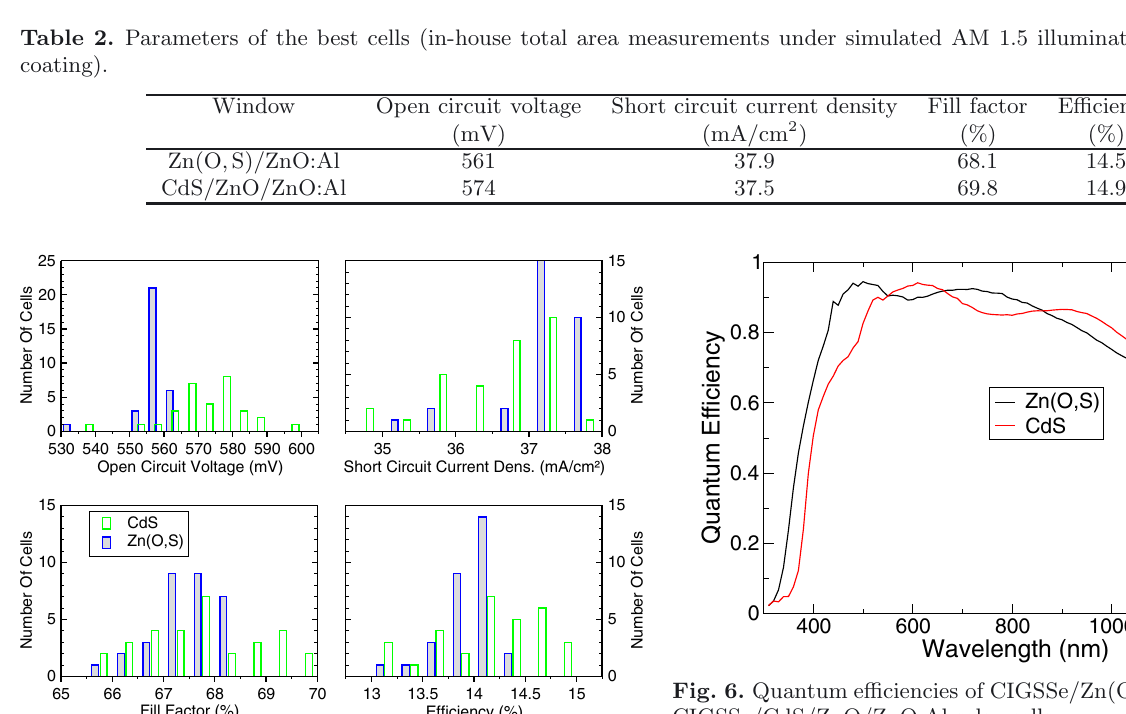
Fig. 5. Distribution of the parameters of small (0.5 cm 2 ) cells with Zn(O, S)/ZnO:Al and CdS/ZnO/ZnO:Al windows on 5 × 5 cm 2 substrates (see text) as measured under simulated AM 1.5 illumination.